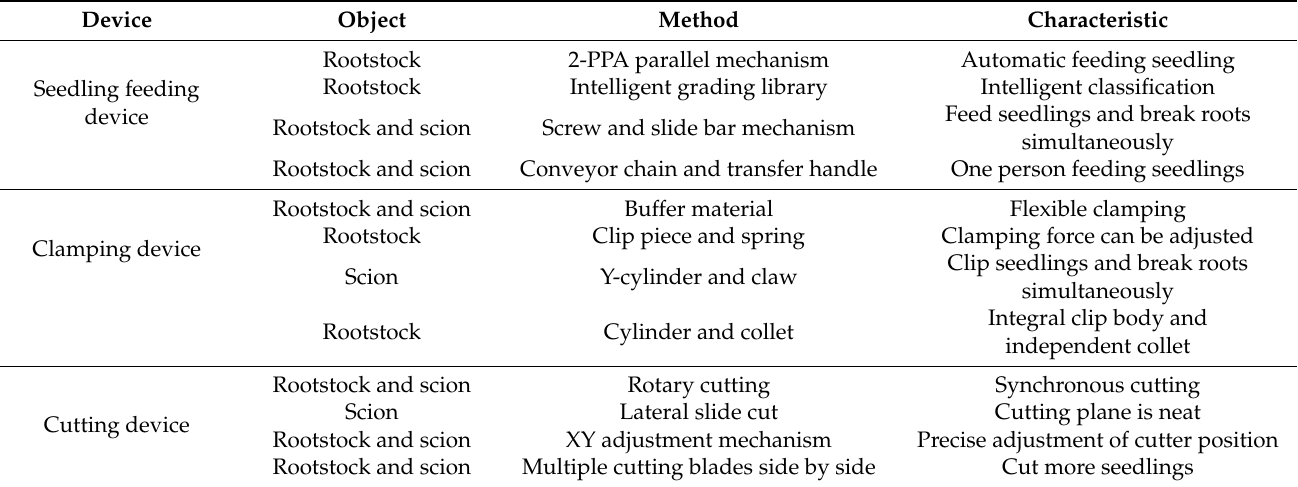
Table 5. Comparison of key grafting device